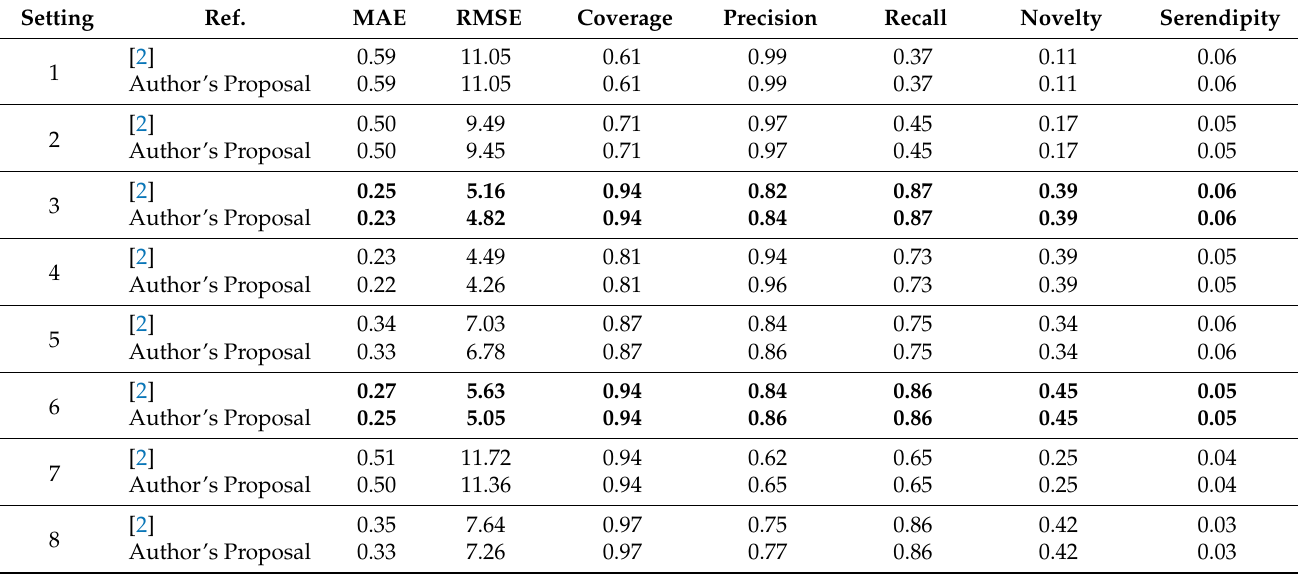
Table 7. Metrics for the different RS for the whole